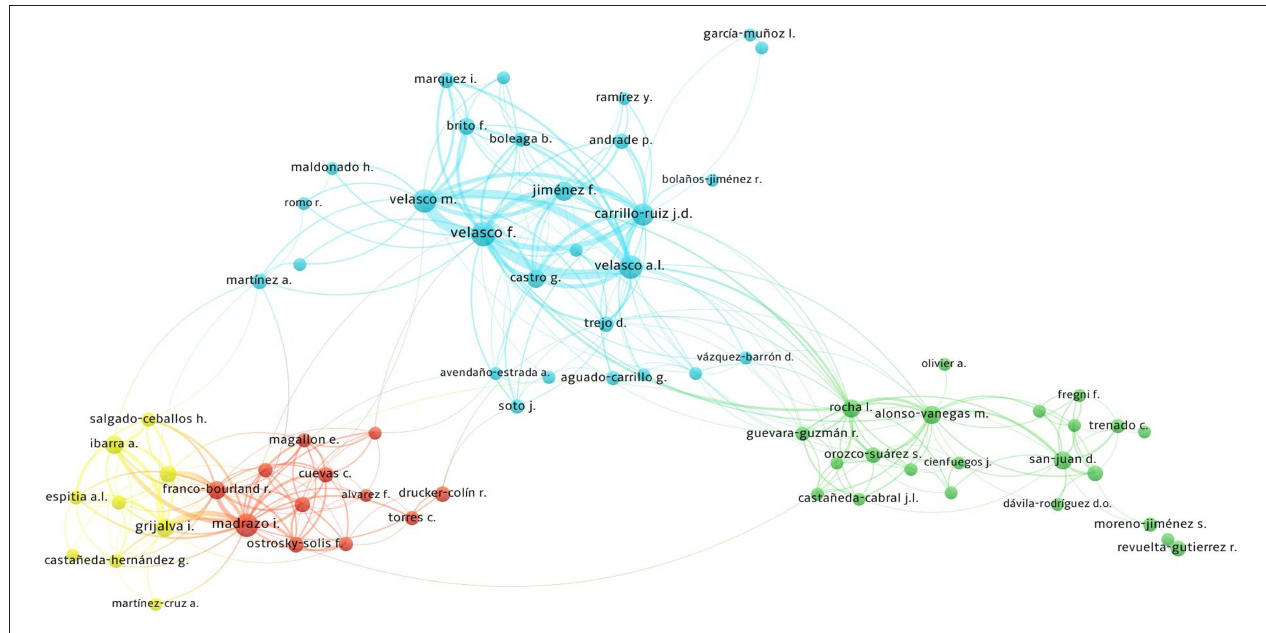
FIGURE 5 | Bibliometric network made in VOSviewer version 1.6.16. The network analysis shows the relationship between the different authors belonging to the most productive institutions in the country, highlighting those authors/groups that presented more collaborations. Institutions are represented by different colors: Hospital General de México ( blue ), Instituto Nacional de Neurología y Neurocirugía ( green ), Centro Médico Nacional Siglo XXI ( red ), and Centro Médico Nacional “La Raza” ( yellow